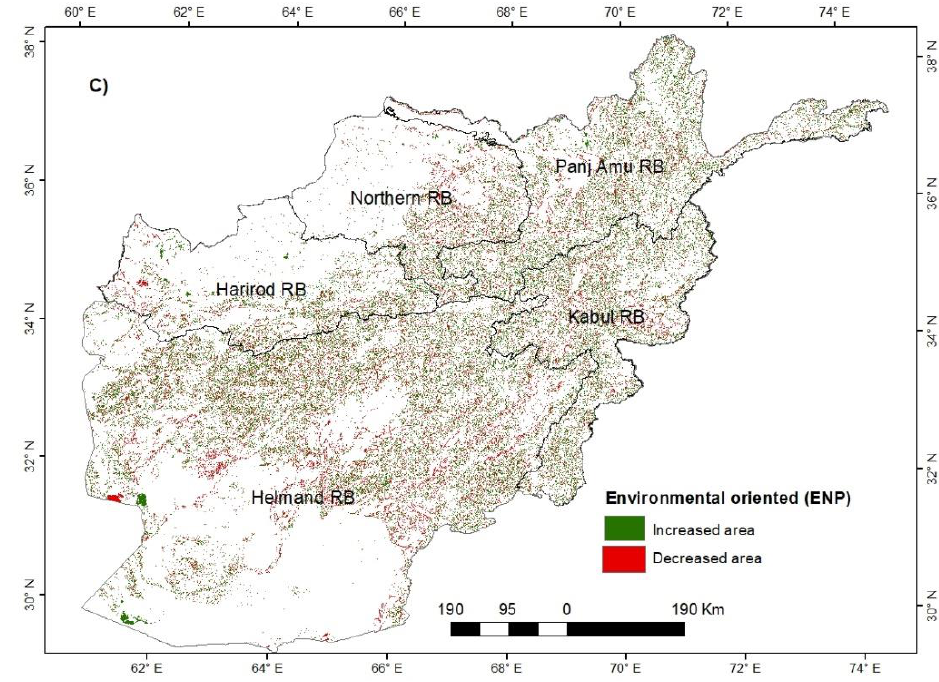
Figure 10. Spatial distribution of predicted LULC in 2030 under the ENP scenario; ( A ) overall simulated LULC; ( B ) Simulated changes in economic-oriented LULC types ( C ) Simulated changes in environmental-oriented LULC classes.